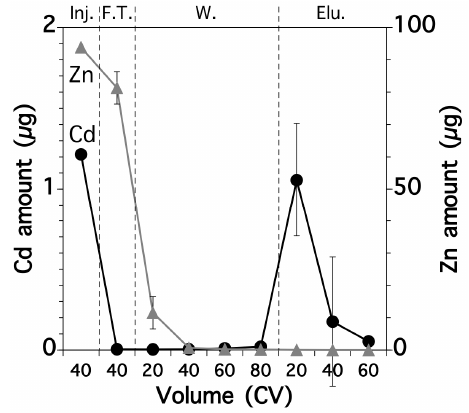
Figure 5. Amounts of Cd and Zn from a real rice sample in each CV of each column fraction. Inj.: injection; F.T.: flow-through fraction; W.: washout fraction; Elu.: elution fraction. Error bars indicate the standard deviation, which was determined using three